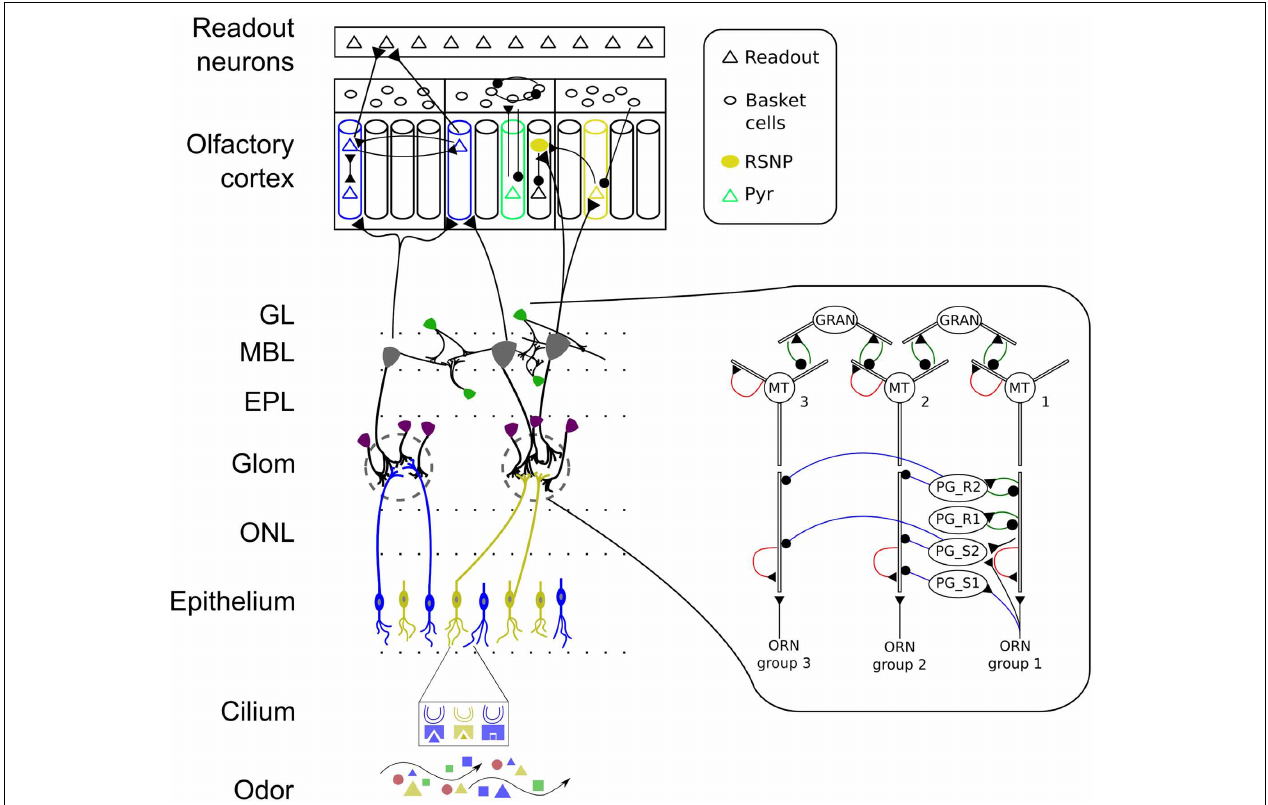
FIGURE 1 | Schematic of the early stages of the mammalian olfactory system. Odors bind to receptors in the cilia of ORNs and lead to input currents based on the affinity between odorant and OR and on the ORN sensitivity. ORNs expressing the same OR make excitatory connections with PG and MT cells in one glomeruli. PG cells show different dendritic arborization patterns and interact with MT cells of the same glomerulus through serial synapses (blue line with dot) and reciprocal synapses (green). MT cells have AMPA and NMDA auto-receptors (shown in red) on their distal primary and secondary dendrites providing self-excitation. Granule cells connect with MT cells through reciprocal synapses. MT and granule cells interact across glomerular modules throughout the OB granule cell layer. MT cells have afferent projections to excitatory pyramidal (PYR) and inhibitory